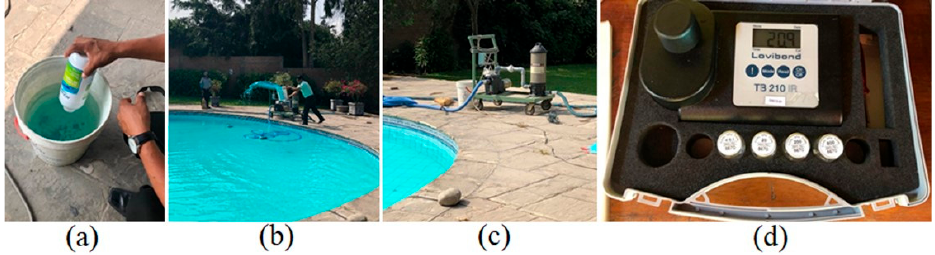
Figure 6. Steps for changing and measuring turbidity: ( a ) add a copper sulfate compound to some pool water in a container; ( b ) pour the mixture into the pool using an electric pump; ( c ) recirculate the pool water with the help of an electric pump; ( d ) measure the water turbidity using a turbidity meter.